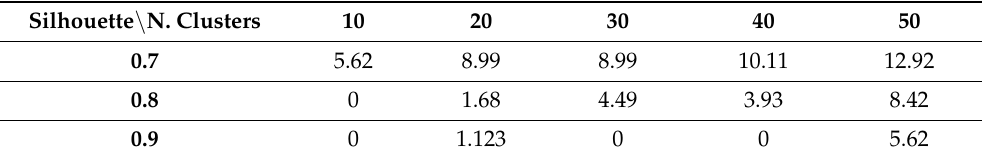
Table 29. Clustering performance in terms of silhouettes using the reduced dataset with PCA applied to normalized data. Silhouette \ N. Clusters